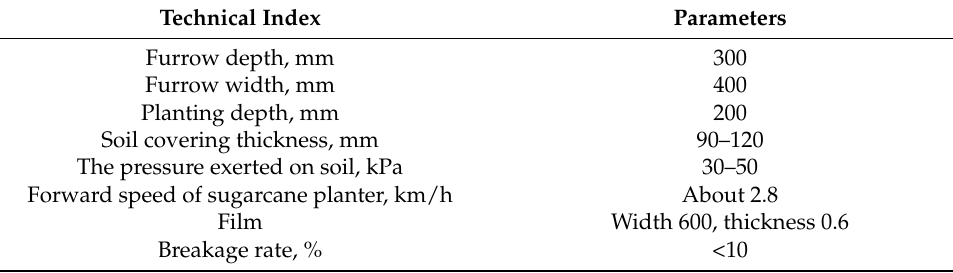
Table 1. Agronomic standards for sugarcane transverse planting.